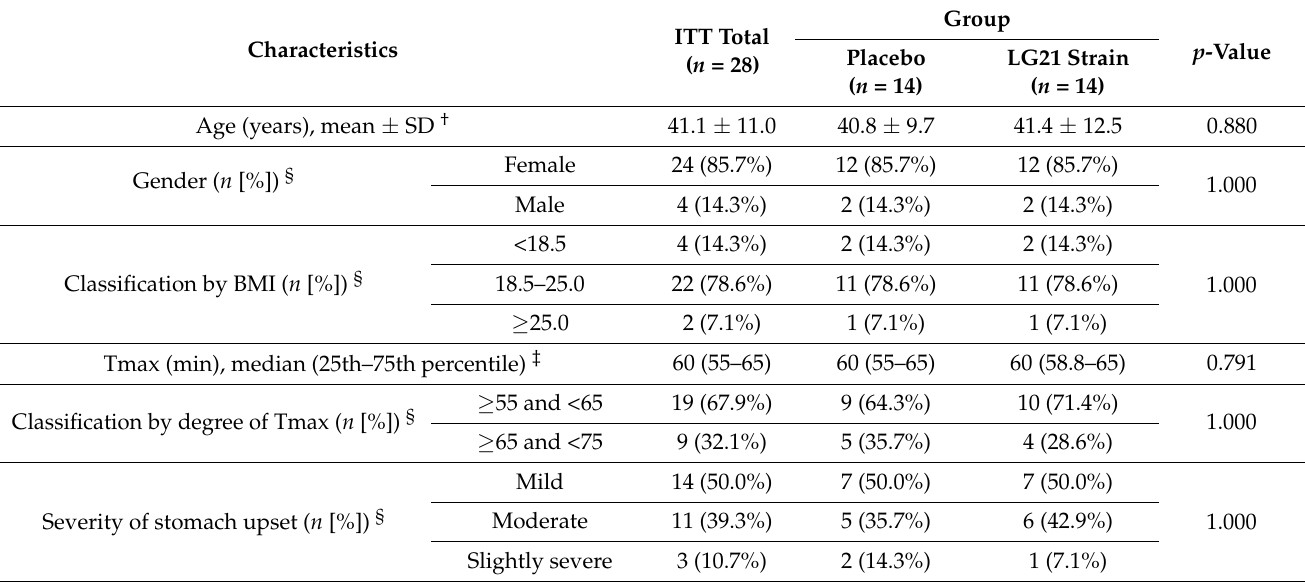
Figure 2. Study flow: The study flow is presented in Figure 2. SCR, screening; PP, per protocol. Table 1. Baseline characteristics of the participants (ITT).